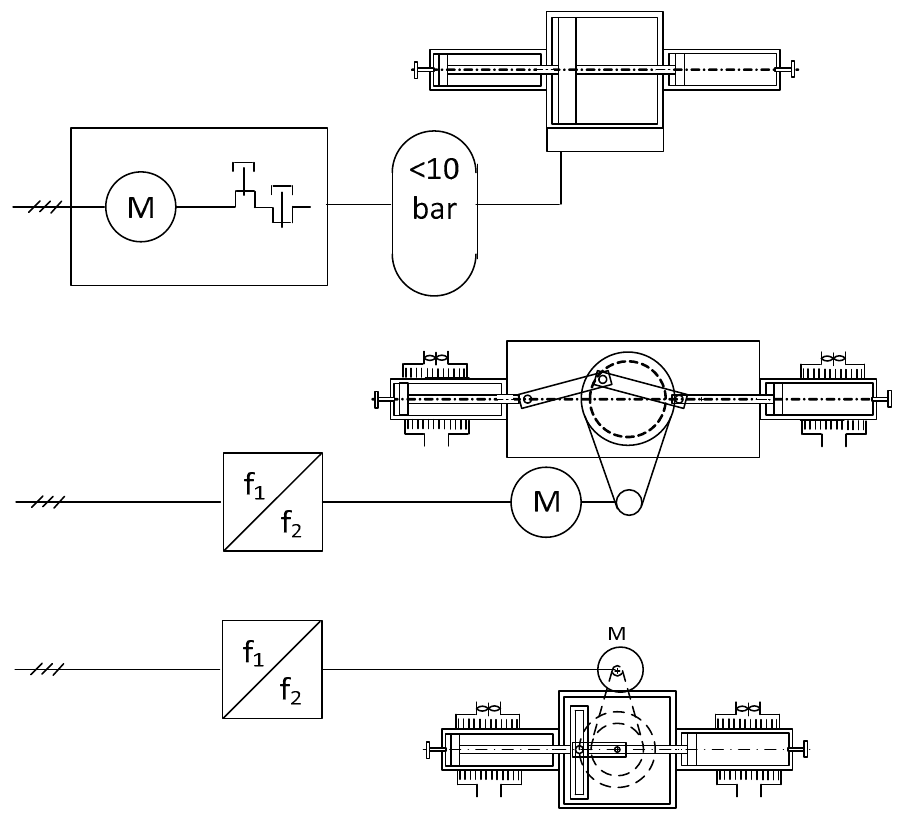
Figure 4. The different architectures of the gas booster.